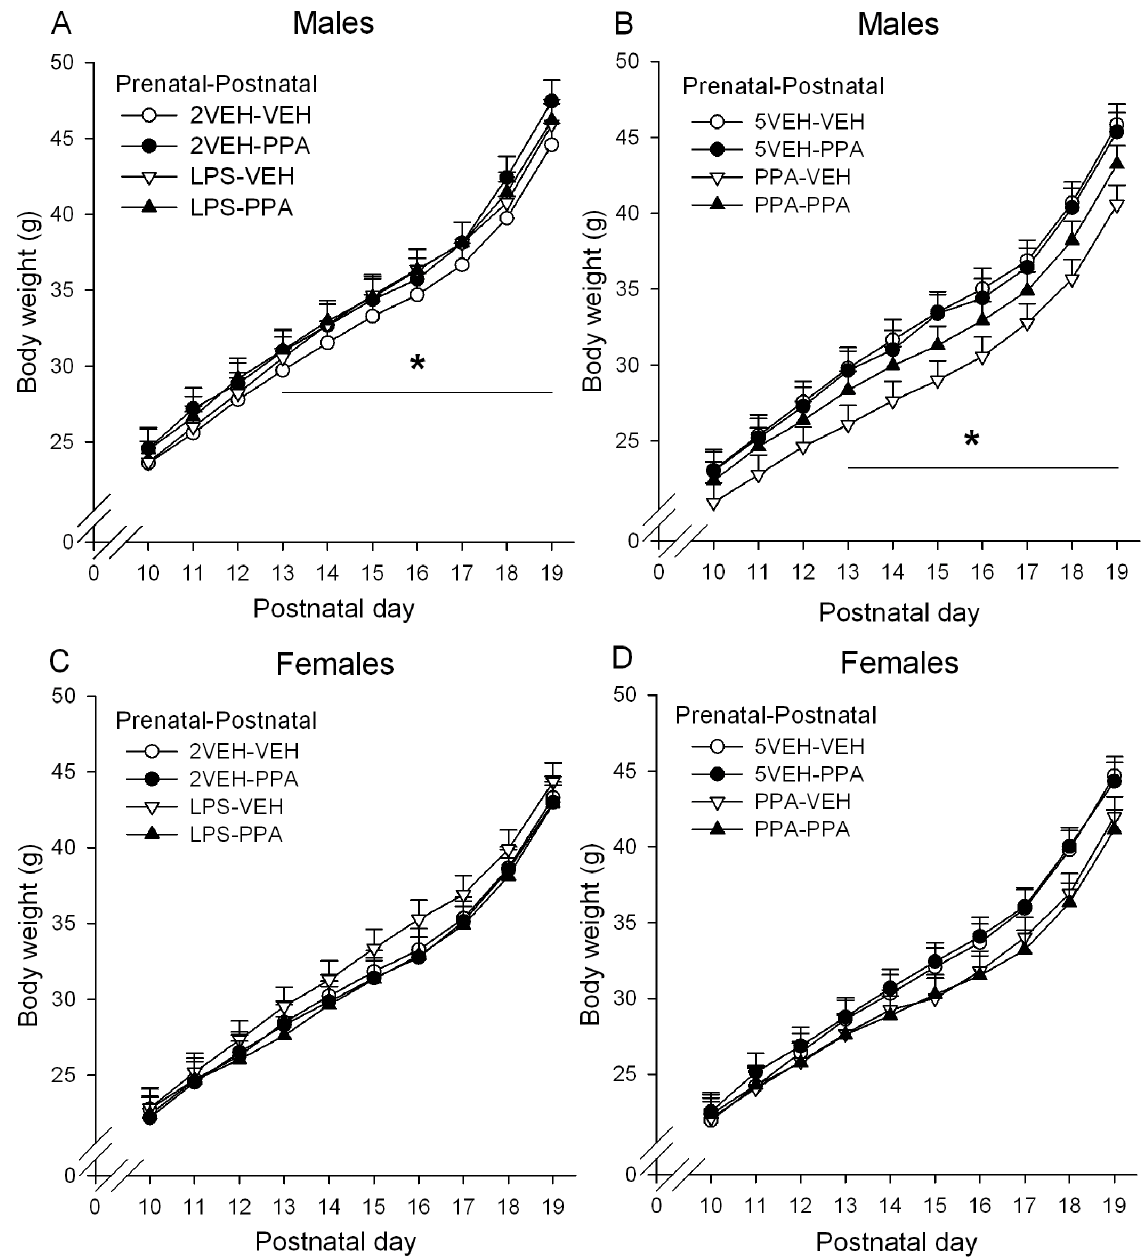
Figure 2. Body weight (g) for male and female offspring from postnatal days 10–19. A–B Males. C–D Females. Rats were prenatally exposed to either lipopolysaccharide (LPS) on G15–16, propionic acid (PPA) on G12–16, or their respective phosphate buffered saline controls (2VEH and 5VEH). Postnatal drug treatment, either PPA or VEH, was administered 2x/day every other day from P10–18. Males receiving postnatal PPA weighed significantly more than postnatal VEH treated males in the prenatal 2VEH (2VEH-VEH vs. 2VEH-PPA in Panel 1A) and prenatal PPA groups (PPA-VEH vs. PPA-PPA in Panel 1B), p s , 0.05. Females receiving postnatal PPA weighed significantly less than postnatal VEH treated females (general effect, p , 0.05). Error bars represent S.E.M. Refer to Table 1 for group designations and sample sizes. doi:10.1371/journal.pone.0087072.g002 There were no effects of prenatal LPS or PPA, or postnatal PPA prenatal and postnatal PPA displayed significantly more revolu- treatment on vertical activity measures (number of vertical tions than their male counterparts ( p =0.001), prenatal PPA- movements and vertical movement time). For number of postnatal VEH treated females ( p = 0.046), and female offspring revolutions, the Sex 6 Prenatal drug 6 Postnatal drug interaction exposed to prenatal LPS or 2VEH and postnatal PPA ( p s , 0.05). was nearly significant, F (3,93) = 2.68, p = 0.051. Further analysis Overall, prenatal PPA, prenatal LPS, and postnatal PPA alone showed that a double hit of prenatal and postnatal PPA increased did not produce hyper- or hypo-activity in male and female the number of revolutions made in the female offspring, but not in adolescent offspring. Prenatal PPA and postnatal PPA combined the male offspring (Figure 4D). Female offspring exposed to